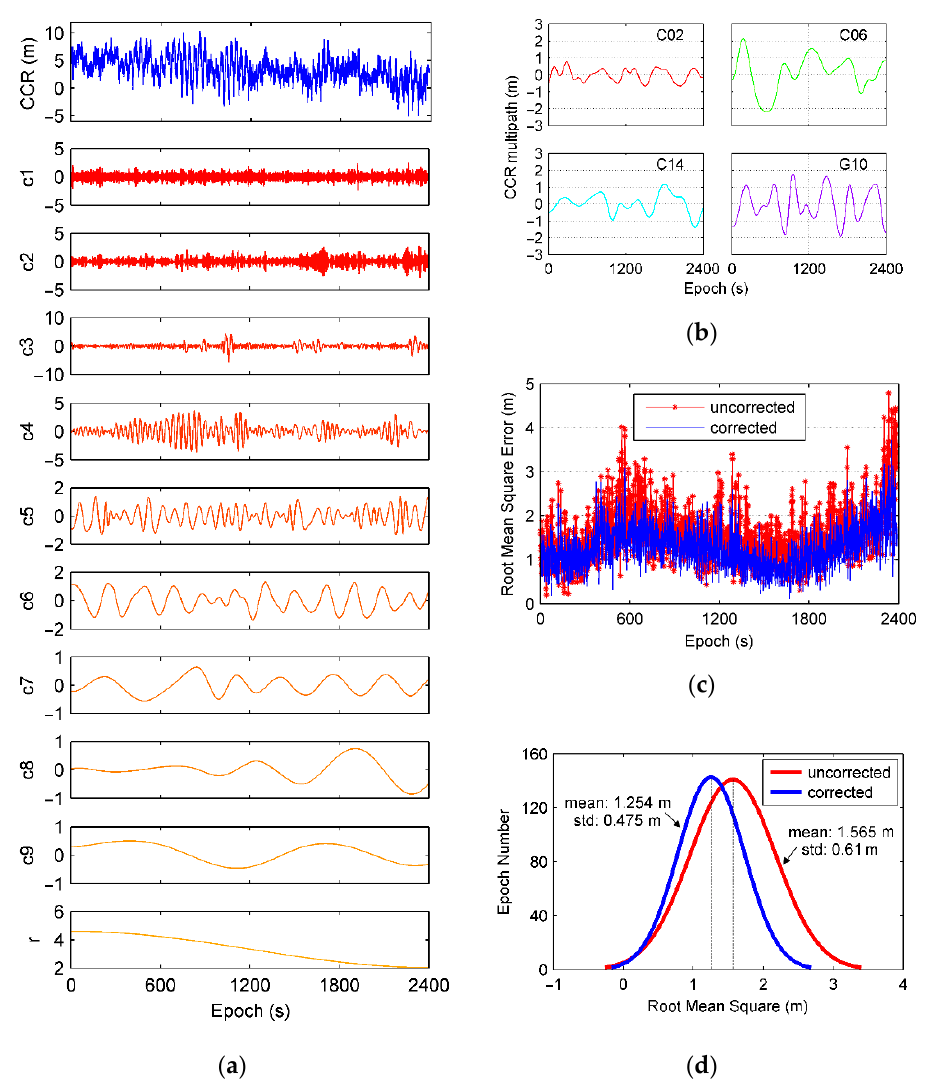
Figure 22. ( a ) Decomposed layers for CCR of satellite C14 using EMD approach, ( b ) is multipath of CCR extracted, ( c ) is the root mean square error in DGNSS experiment, and ( d ) is the distribution of root mean square for positioning result.